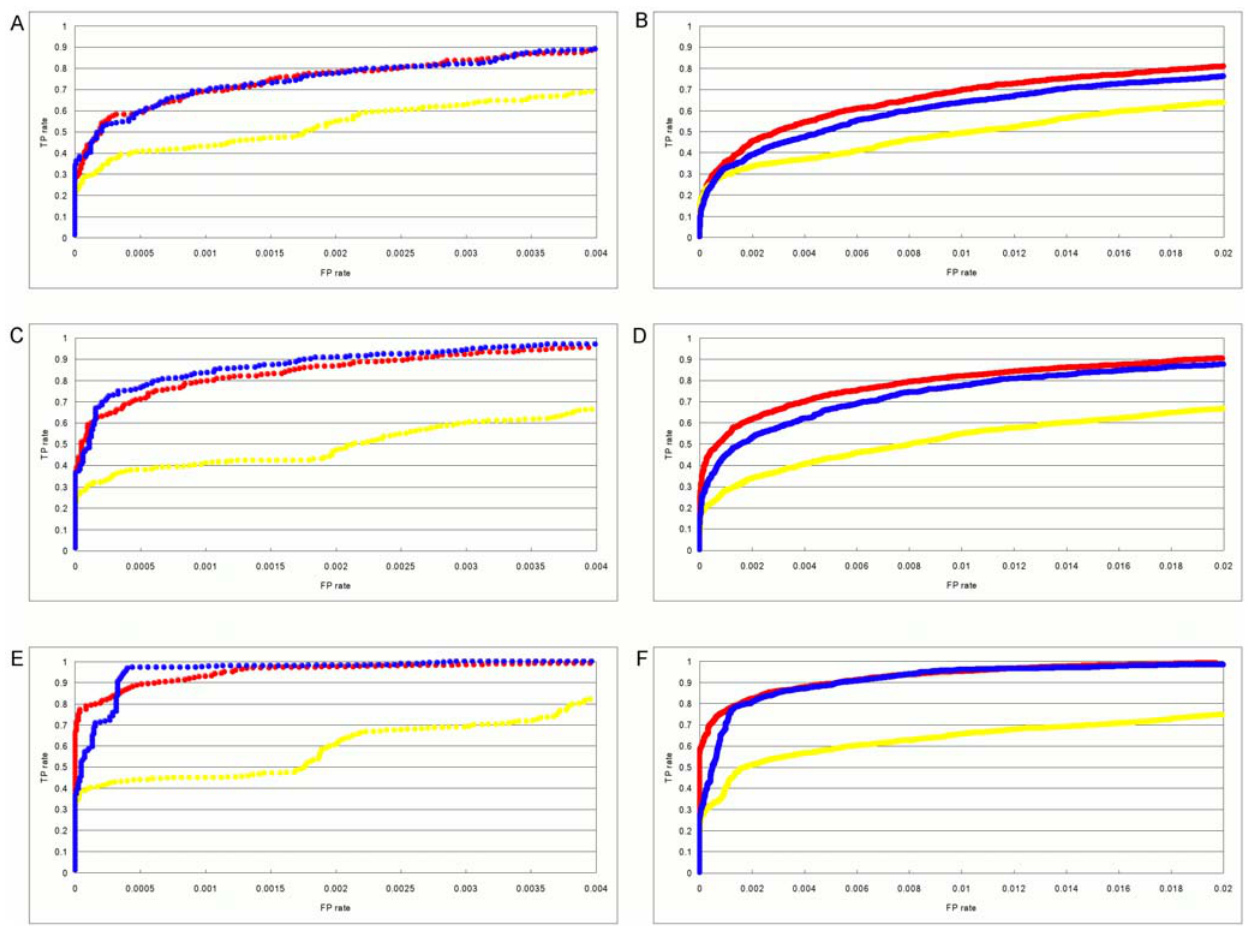
Figure 6. Receiver operator characteristic curves of the position weight matrix models with Boltzmann sampling. The log-odds, Match, and quadratic programming results are denoted by red, yellow, and blue markers respectively. Each data point is the mean of five replicates and points are allowed to overlap. Error as standard deviation of the mean extends from each curve by the size of a single marker. A. Alignments containing 20 sites; cutoff=4. The log-odds, Match, and quadratic programming curves attain TP=1 at FP=0.026, 0.072, and 0.026, respectively. B. Alignments containing 20 sites; cutoff=7. The log-odds, Match, and quadratic programming curves attain TP=1 at FP=0.238, 0.445, and 0.326, respectively. C. Alignments containing 50 sites; cutoff=4. The log-odds, Match, and quadratic programming curves attain TP=1 at FP=0.011, 0.045, and 0.009, respectively. D. Alignments containing 50 sites; cutoff=7. The log-odds, Match, and quadratic programming curves attain TP=1 at FP=0.107, 0.306, and 0.143, respectively. E. Alignments containing 200 sites; cutoff=4. The log-odds, Match, and quadratic programming curves attain TP=1 at FP=0.008, 0.018, and 0.003, respectively. F. Alignments containing 200 sites; cutoff=7. The log-odds, Match, and quadratic programming curves attain TP=1 at FP=0.035, 0.209, and 0.065,